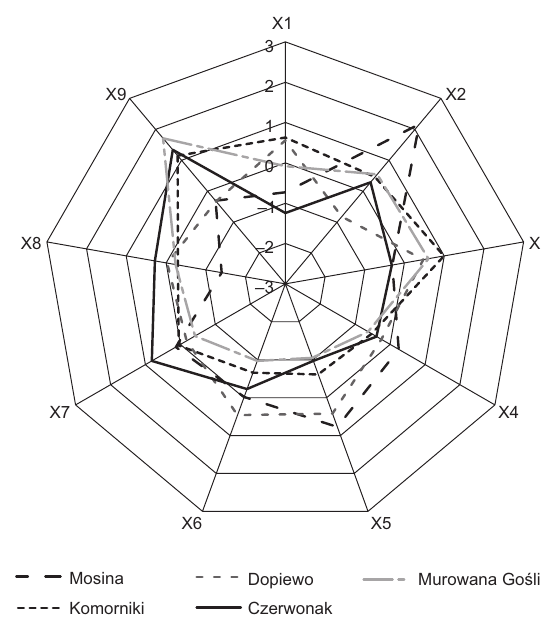
Fig. 2. distribution of the values of normalised indicators in Fig. 3. distribution of the values of normalised indicators in communes with favourable determinants of the quality of communes with average determinants of the quality of life life as compared with the Poznań agglomeration. as compared with the Poznań agglomeration. Source: own material. Source: own material.